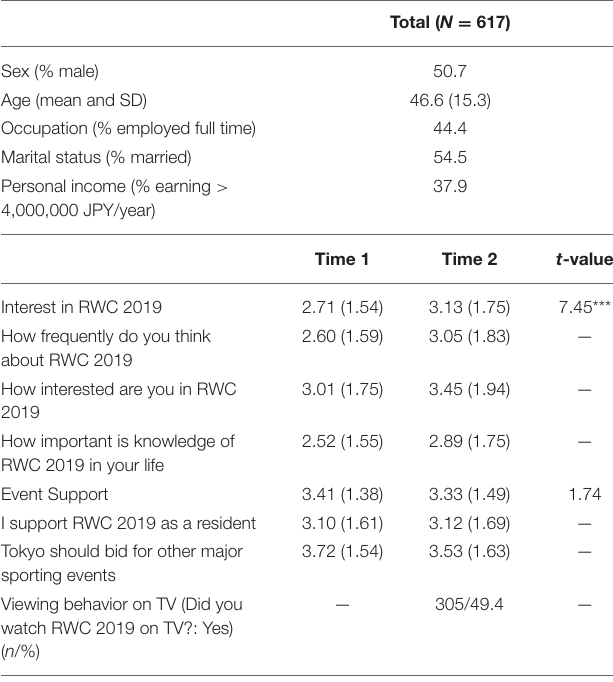
TABLE 1 | Descriptive statistics of the total sample and the